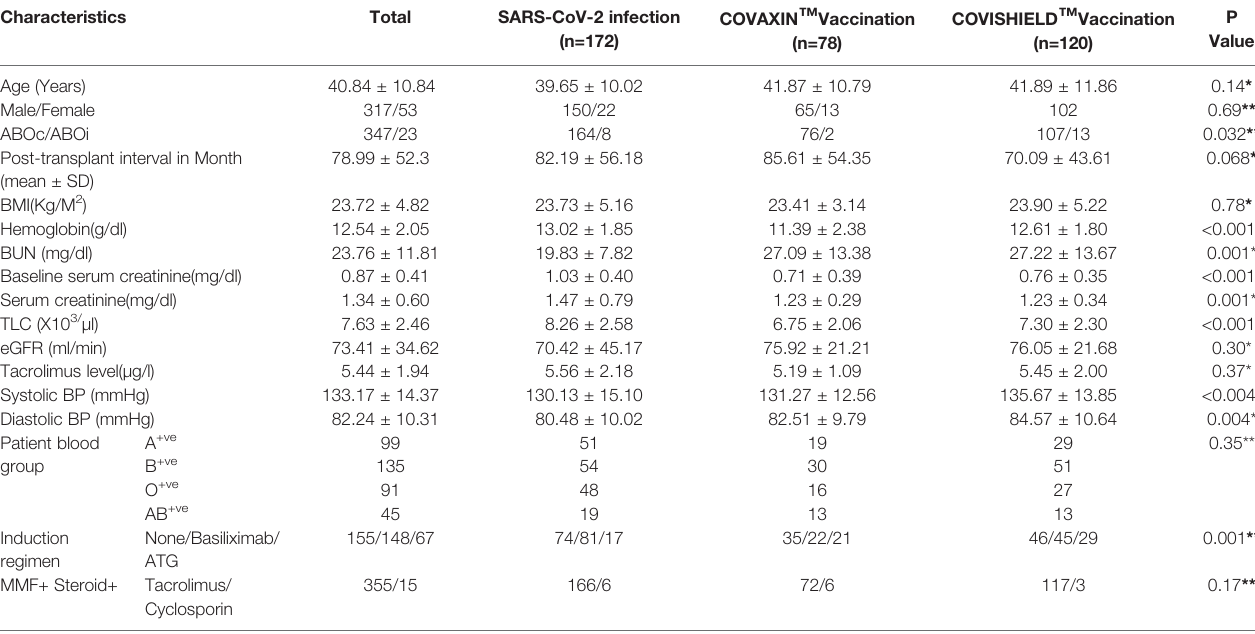
TABLE 1 | Demographic and clinical characteristic of patients in SARS-CoV-2 infection and Vaccination.